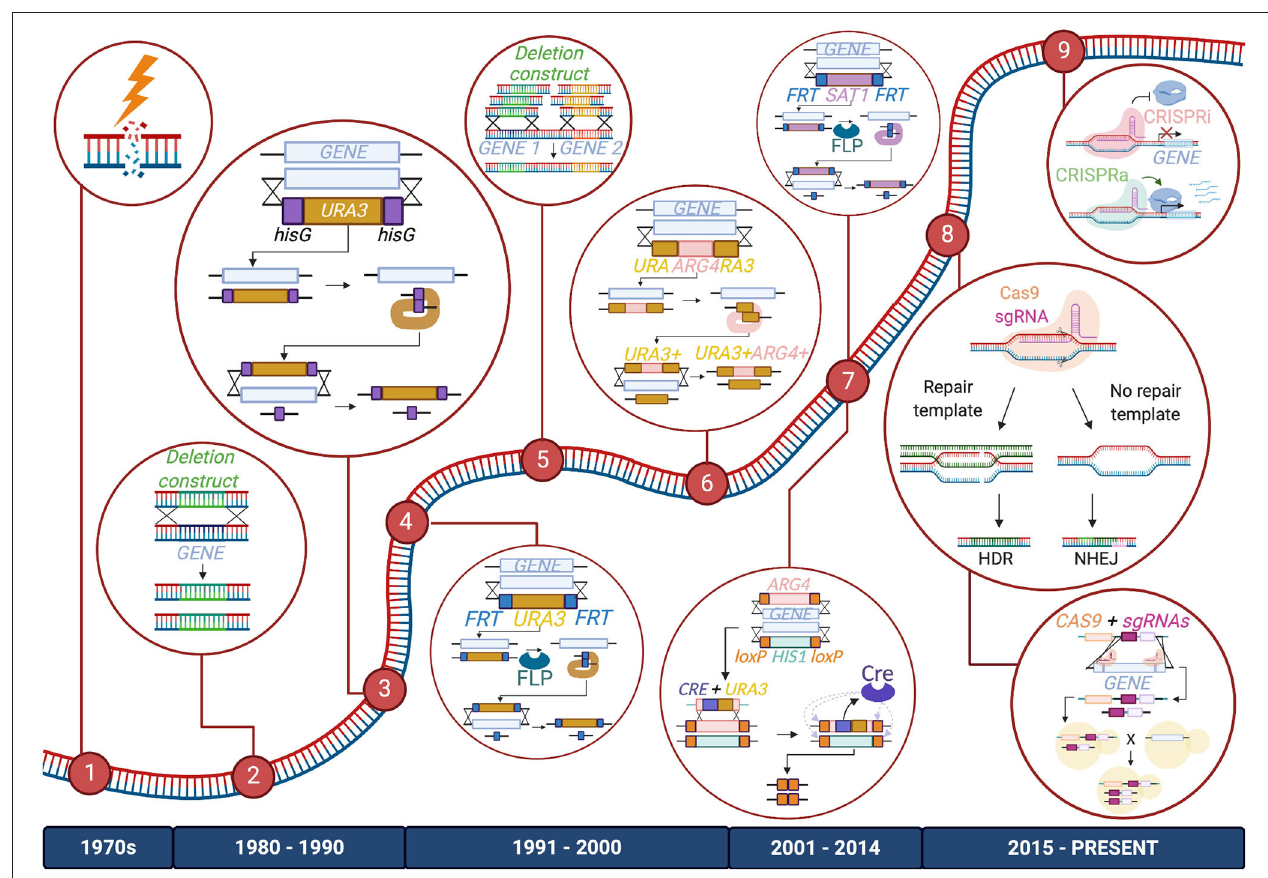
FIGURE 1 | Timeline of advancements made to C. albicans gene manipulation technology. Major methods included in the C. albicans gene editing toolbox are listed from left to right: (1) UV exposure and chemical mutagenesis; (2) Homology-directed repair (HDR) via transformation of a deletion construct or a repair template; (3) URA Blaster; (4) URA Flipper; (5) HDR via transformation of PCR-amplified deletion constructs or repair templates; (6) UAU1 cassette; (7) Cre-LoxP and SAT1/caNAT1 Flipper; (8) CRISPR-Cas9 and CRISPR-Cas9 gene drives; (9) CRISPR interference (CRISPRi) and CRISPR activation (CRISPRa). The diagram depicts these tools as they are used to create homozygous gene deletions, except for CRISPRi and CRISPRa, which are depicted to repress or activate genes, respectively. Enzymes, DNA, and RNA components are not drawn to